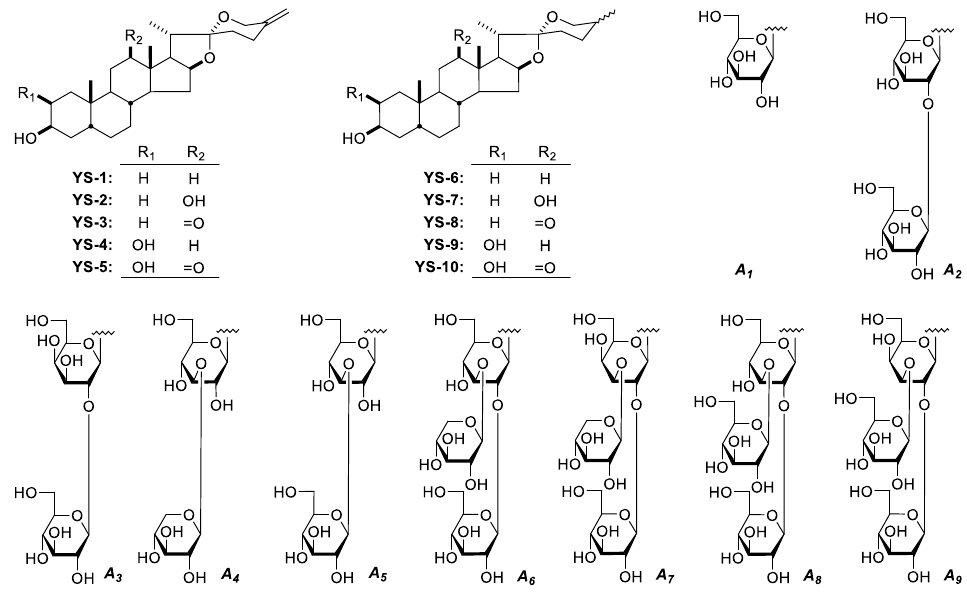
Figure 2. Structures of ten aglycons and nine glycosyls of spirostanol saponins from